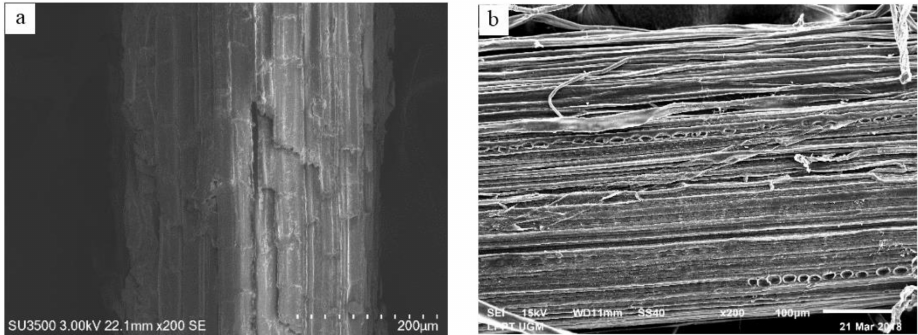
Figure 9. SEM images of ( a ) untreated salacca midrib fibers ( b ) bleached salacca midrib fibers [89]. (Open